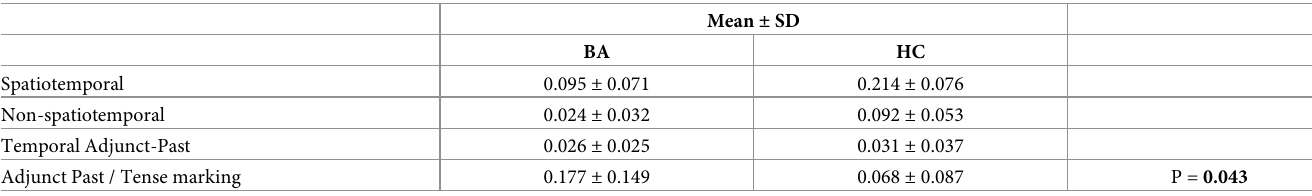
Table 5. Decomposition of within-propositional